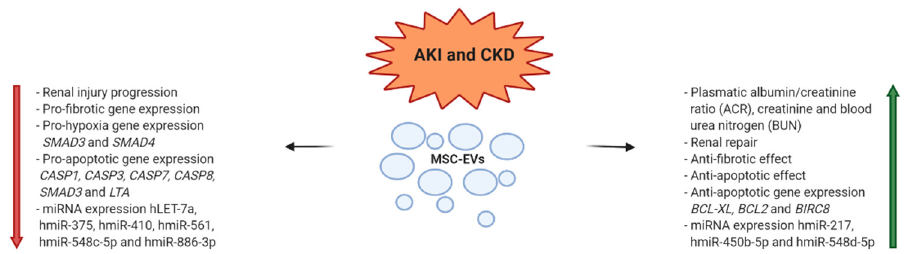
Figure 2. MSC-EV mechanisms of action in modulation of kidney diseases (h = human; m =